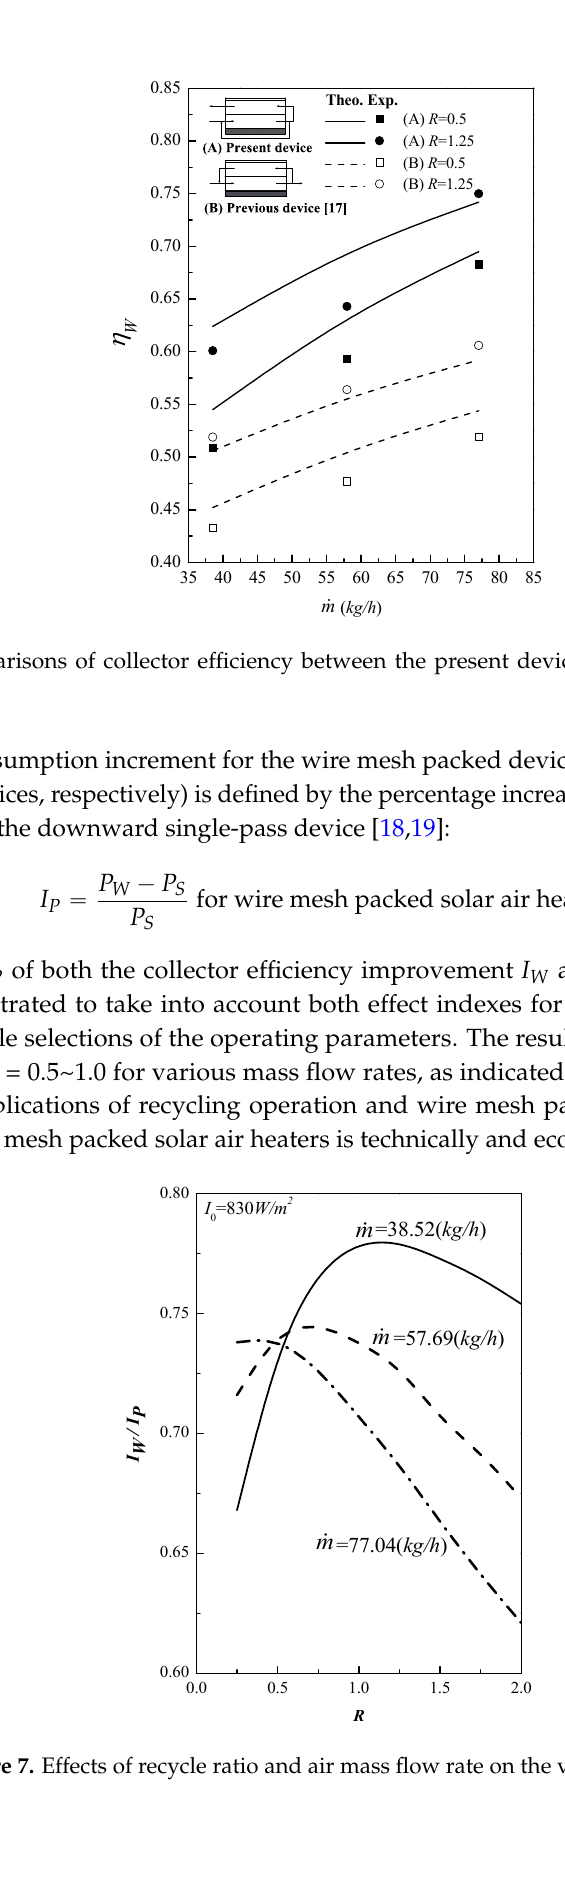
Figure 7. Effects of recycle ratio and air mass flow rate on the value of I W / I P .